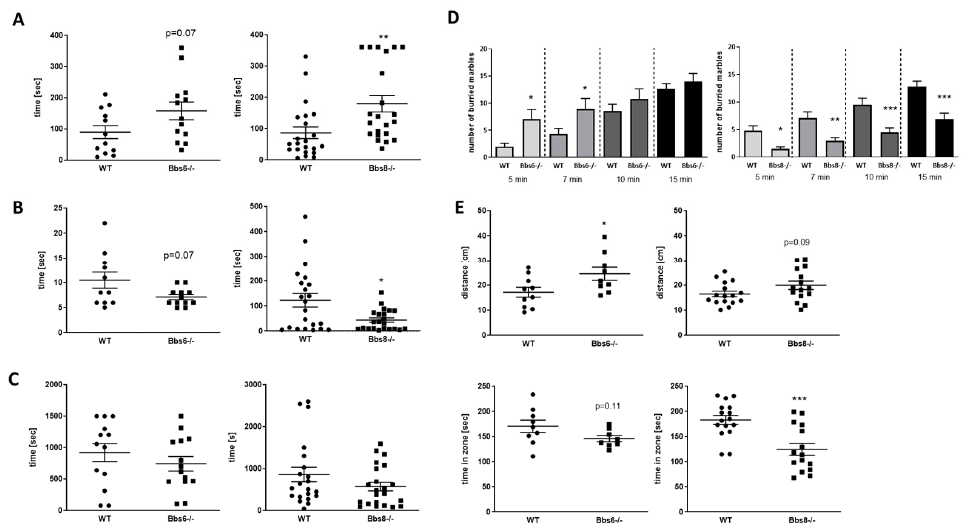
Figure 6. Anxiety-related behavior in Bbs6 and Bbs8 knockout mice. ( A ) Latency to immobile state in the forced swim test ( n = 12 for WT and n = 13 for Bbs6 − / − ; n = 22 for WT and Bbs8 − / − ). ( B ) Time to escape the box in the neophobia test ( n = 11 for WT and n = 10 for Bbs6 − / − ; n = 22 for WT and Bbs8 − / − ). ( C ) Novelty induced suppression of feeding was measured in a modified open field arena ( n = 13 for WT and n = 14 for Bbs6 − / − ; n = 22 for WT and Bbs8 − / − ). ( D ) The number of buried marbles per time period is shown ( n = 13 for WT and n = 14 for Bbs6 − / − ; n = 22 for WT and Bbs8 − / − ). ( E ) Distance travelled within the first 5 min and time spent in the corners (first 5 min) in the open field arena ( n = 8 for WT and n = 9 for Bbs6 − / − ; n = 22 for WT and Bbs8 − / − ). Examples of heat maps for movement profile visualization are given in Supplementary Figure S1. Student’s unpaired t -test was used for statistical analysis (* p < 0.05; ** p < 0.01; *** p < 0.001).